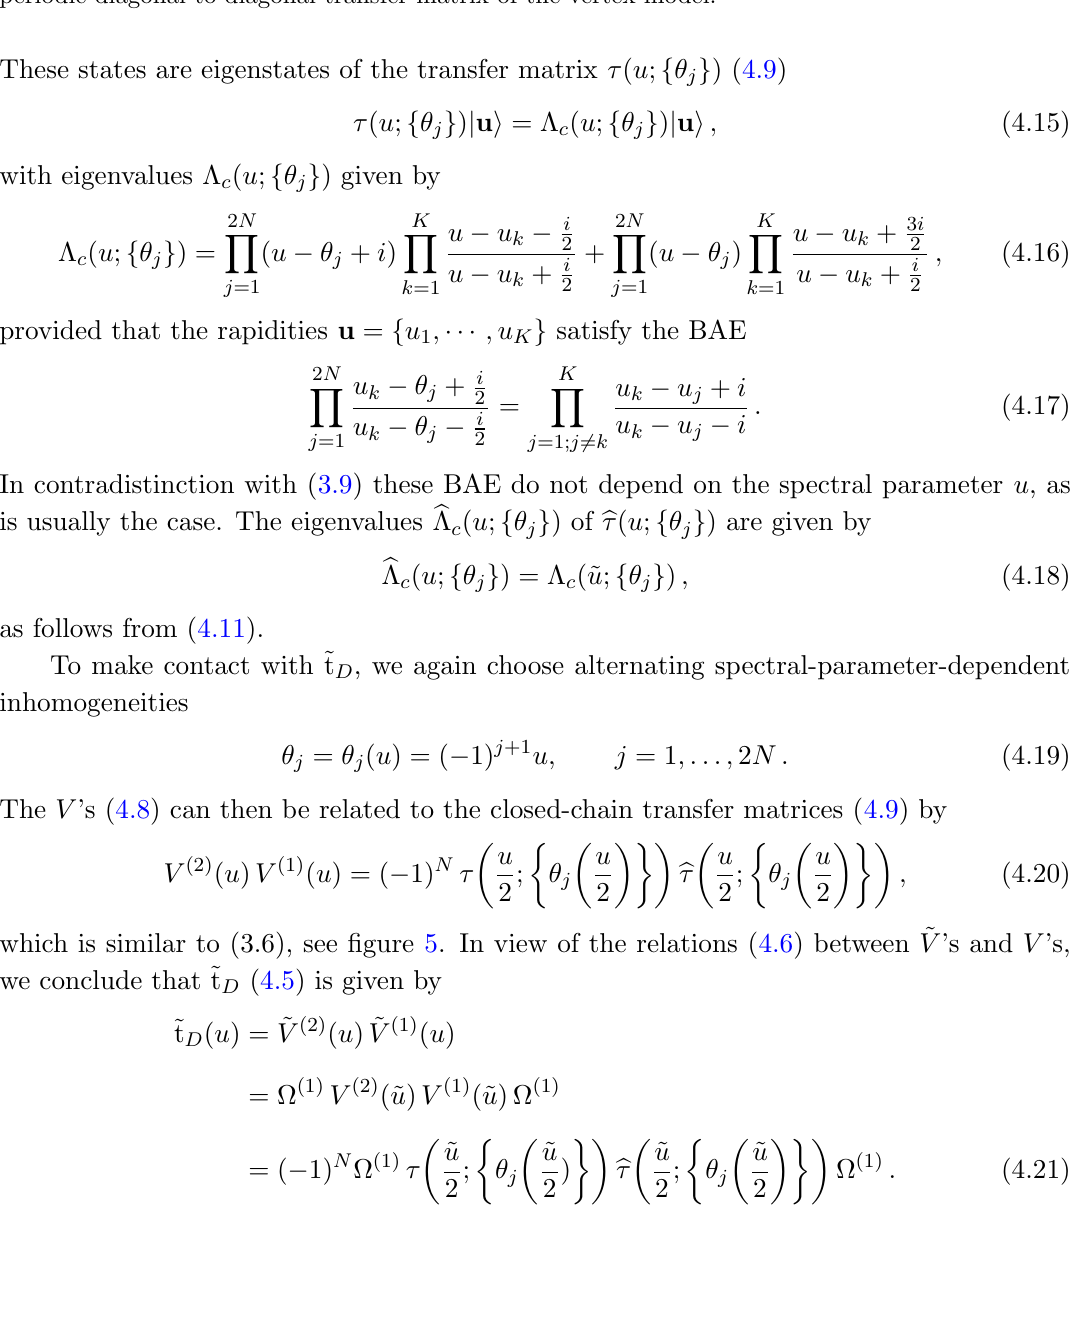
Figure 5 . The R -matrices with zero argument act as permutation operators depicted with avoiding lines. This transforms the product of periodic transfer matrices of the spin-chain geometry into the periodic diagonal-to-diagonal transfer matrix of the vertex